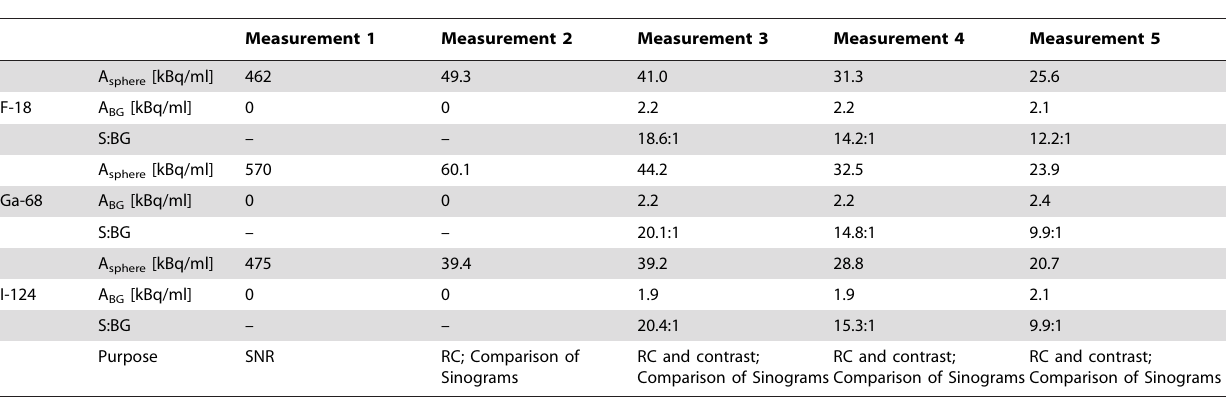
Table 1. Specific activities and sphere-to-background-ratios used in PET-measurements.